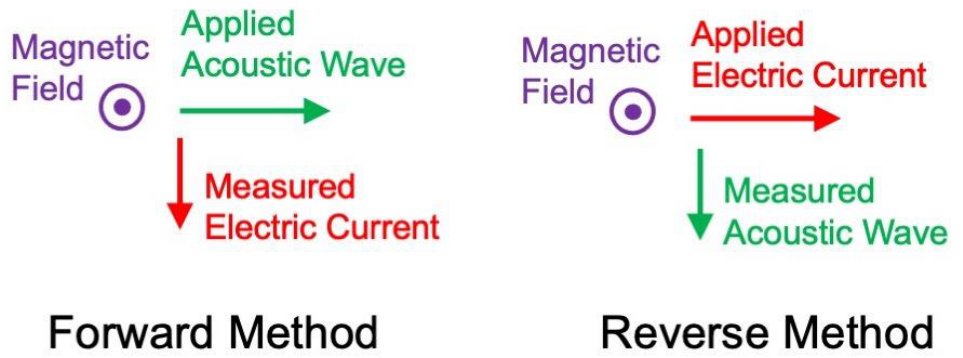
Figure 3. The forward and reverse methods to perform magneto-acoustic imaging.